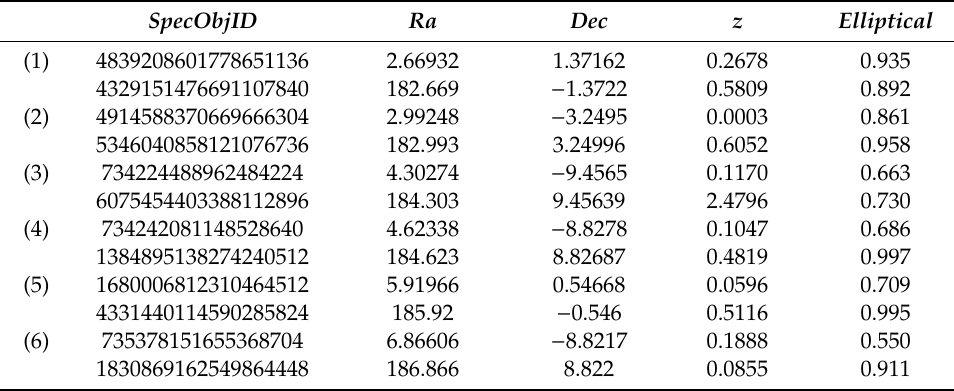
Table A7. Pairs of elliptical galaxies (with parameter elliptical > 0.5) for the e ff ect of cosmic lens